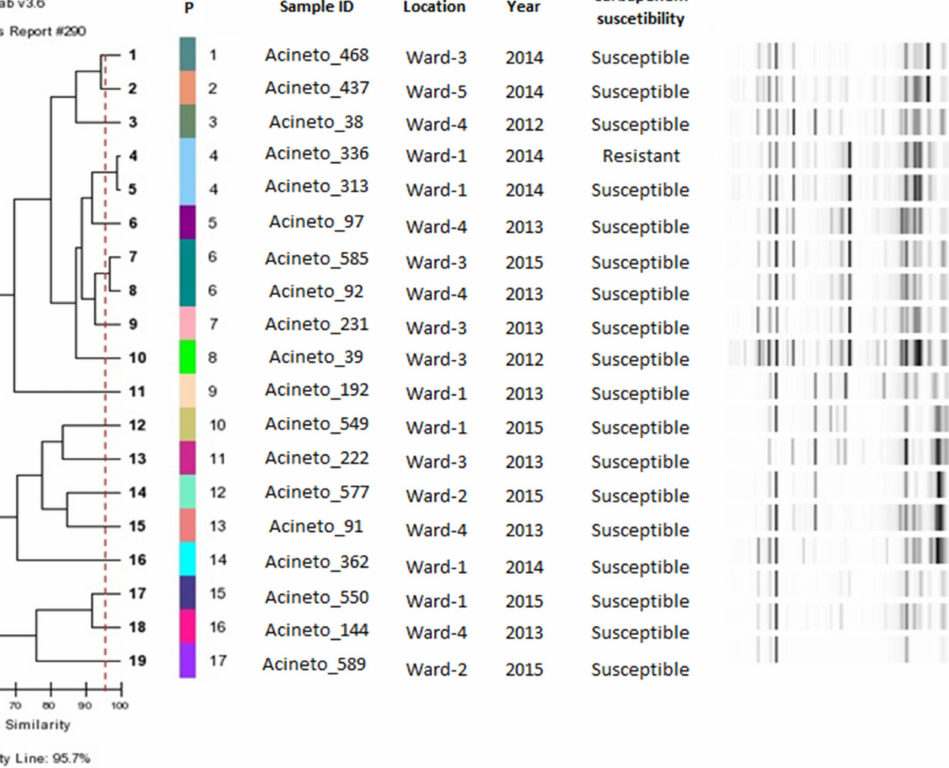
Figure 2. Dendrogram of A. nosocomialis isolates analysed in the study. Abbreviations: P: Patterns (number of genetic patterns identified by DiversiLab System analysis, formed with ≥ 95% similarity). Sample ID: Identification of A. nosocomialis isolates obtained from surgical site of caesarean section patients. Location: Obstetric wards in which women remained after caesarean section